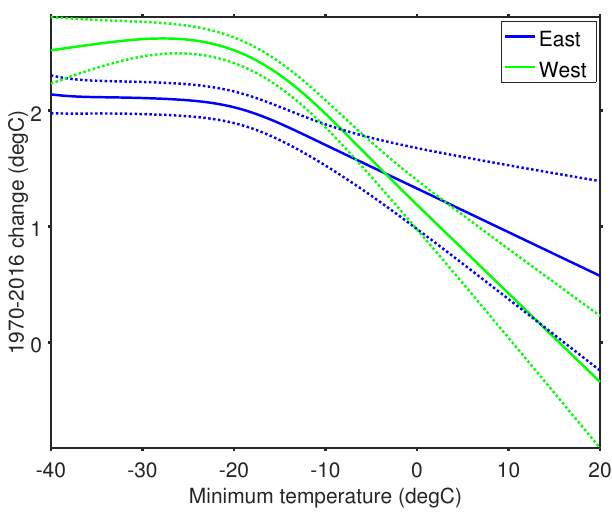
Figure 5. Mean warming in annual minimum temperature over 1970–2016, as a function of climatology (1976–2005) using annual minimum temperature, calculated separately for the Eastern and Western Hemisphere midlatitudes. Dashed lines show 95% confidence intervals of the smoothed relationships.